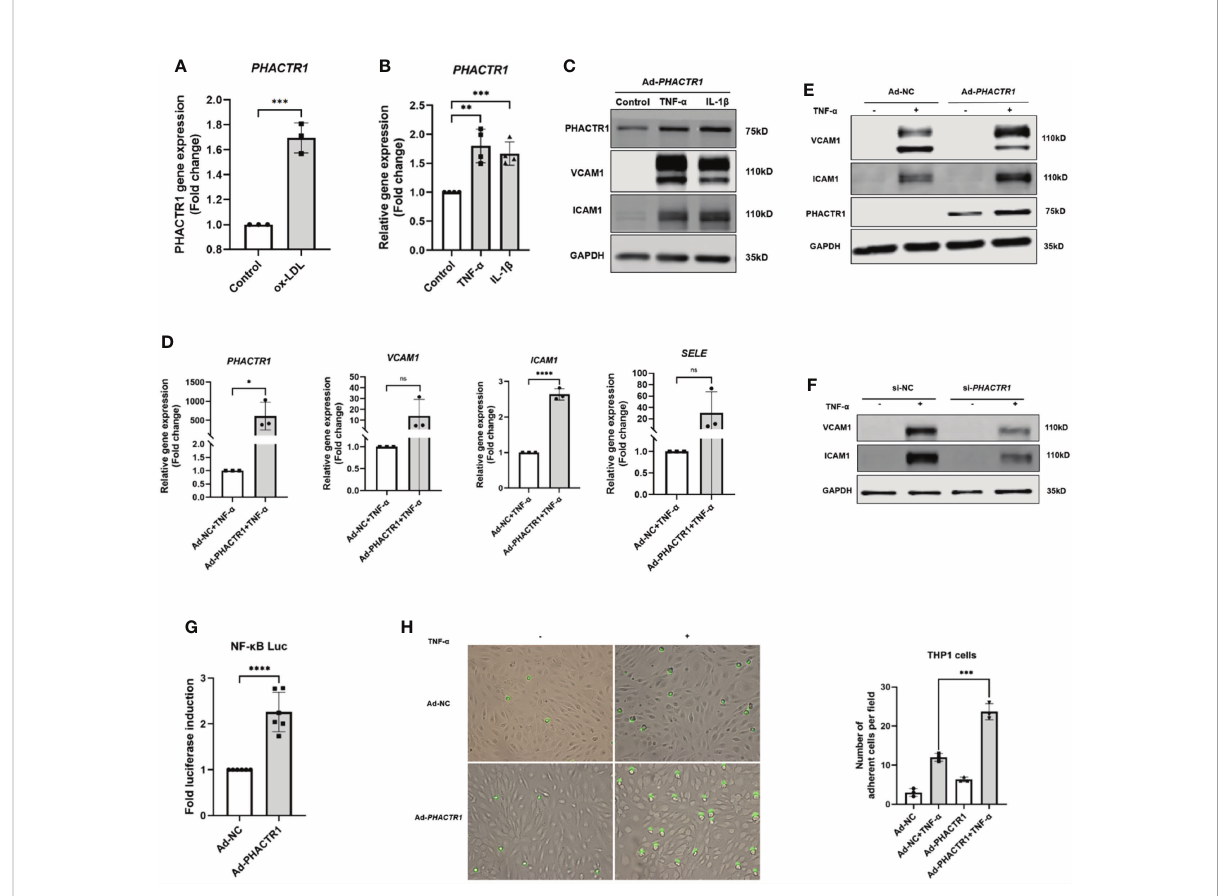
FIGURE 2 PHACTR1 mediates endothelial in fl ammation. (A) PHACTR1 mRNA level was upregulated by ox-LDL (50 m g/mL, 6 h) in HUVECs (n = 3). (B) PHACTR1 mRNA level was upregulated under TNF- a and IL-1 b (10 ng/mL, 24 h) in HUVECs (n = 4). (C) PHACTR1 protein level was upregulated under TNF- a and IL-1 b (10 ng/mL, 24 h) in HUVECs (n = 5). (D, E) PHACTR1 overexpression enhanced VCAM1, ICAM1 gene and protein expression under TNF- a stimulation (10 ng/mL, 6 h) in HUVECs (n = 3 or 6). (F) PHACTR1 silencing suppressed VACM1 and ICAM1 protein expression under TNF- a stimulation (10 ng/mL, 6 h) in HUVECs (n = 3). (G) PHACTR1 overexpression activated NF- k B luciferase activity (n = 6). (H) PHACTR1 overexpression aggravated the adhesion of THP1 cells under TNF- a stimulation (10 ng/mL, 6 h) in HUVECs (n = 3). ns, non- signi fi cant, *P < 0.05, **P < 0.01, ***P < 0.001, ***P < 0.0001 ****, P <